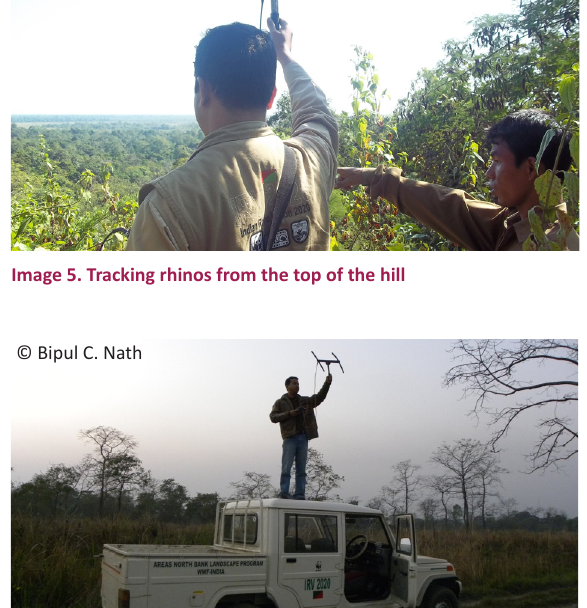
Image 6. Rhino tracking from the top the vehicle by the researcher